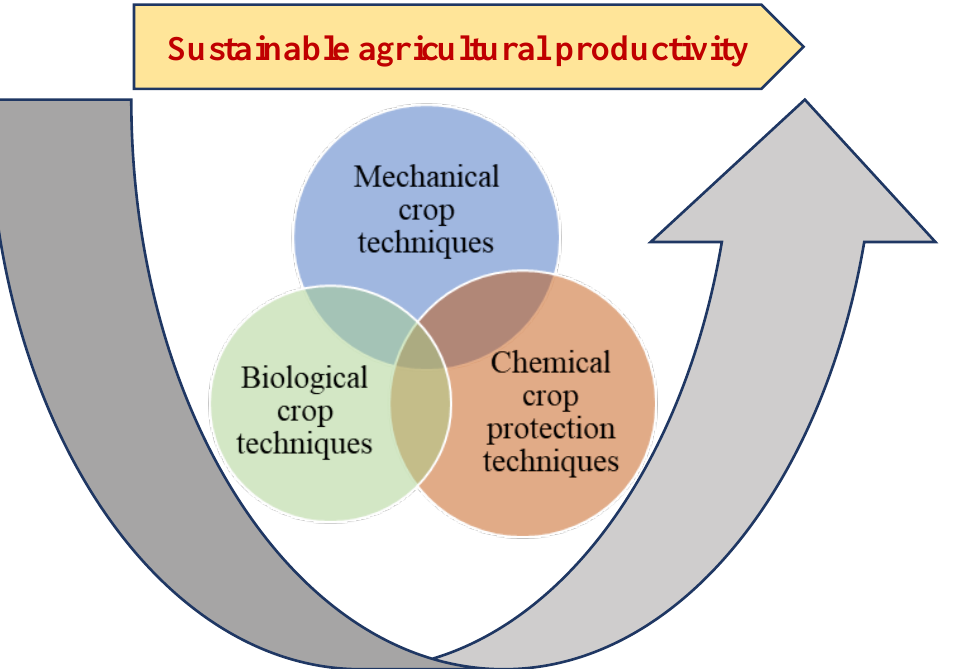
Figure 1. Sustainable agricultural productivity.